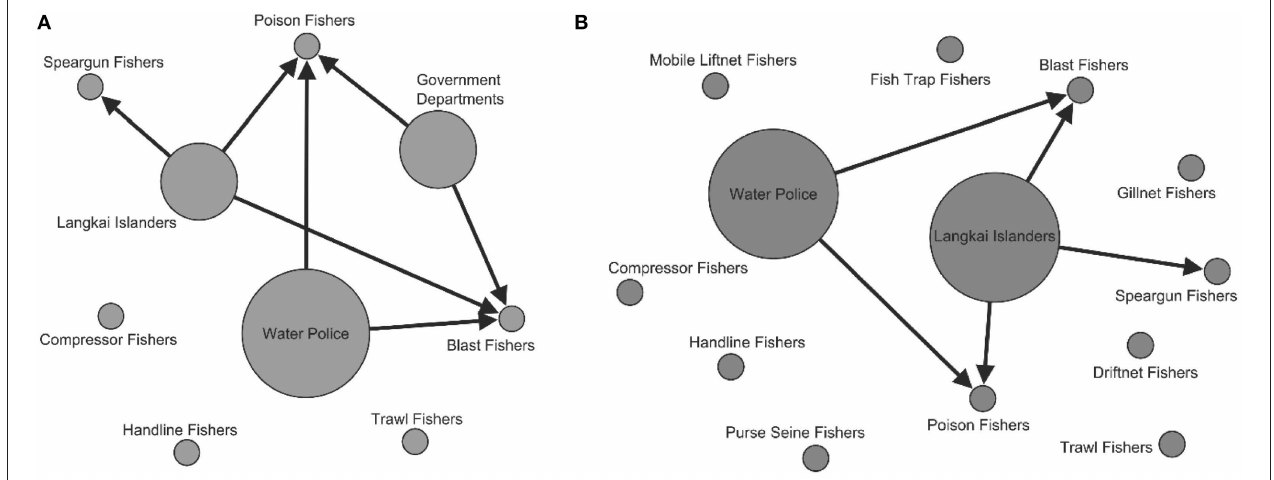
FIGURE 3 | Managing marine resources in the Langkai Island Waters. The figure shows the perceived impact of the state CPRR and the CBM on marine resource use in the Langkai Island Waters based on the Net-Map group interviews with fishers from Barrang Lompo Island (A) , and with fishers from Langkai Island (B) . The arrows indicate that an actor exercises influence toward another actor in the Langkai Island Waters. The size of the dots is scaled to the perceived influence of the actor on resource use in the area on a scale between 1 and 4 (the larger the dots, the higher is the perceived influence).